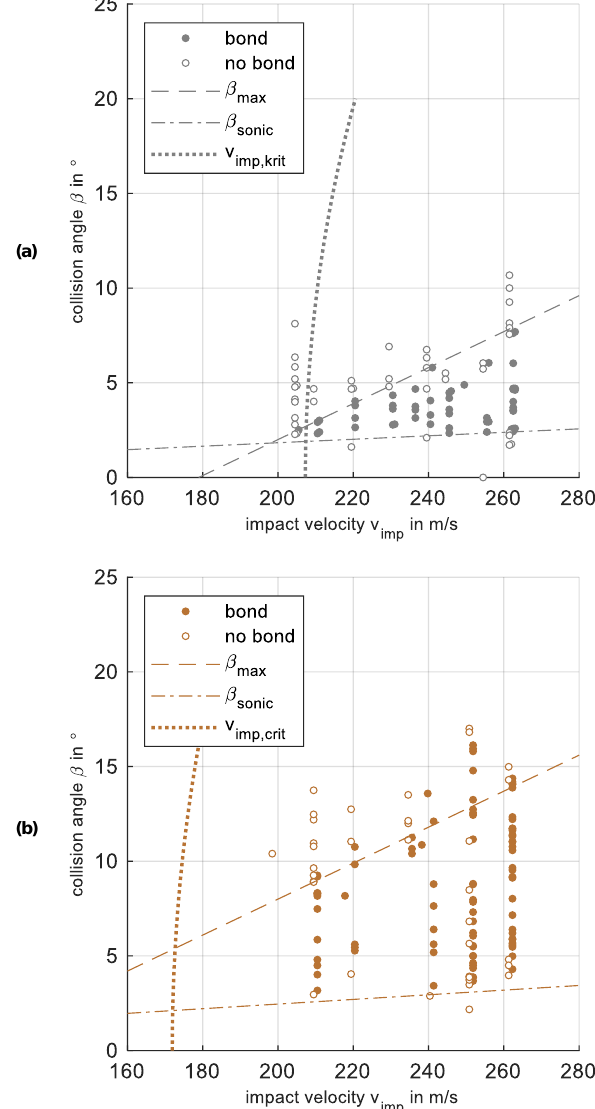
Figure A1. The welding windows for similar combinations of Al–Al ( a ) from [20] and Cu–Cu ( b ) from [21]. To improve the visibility of the data points, welded experiments are plotted with +0.5ms − 1 , non-welded with − 0.5ms − 1 . v imp,krit is the minimal impact velocity calculated by Equation 2. The subsonic boundary angle β sonic represents the surpassing of the speed of sound in the material by the collision point velocity. The upper collision angle boundaries β max were linear